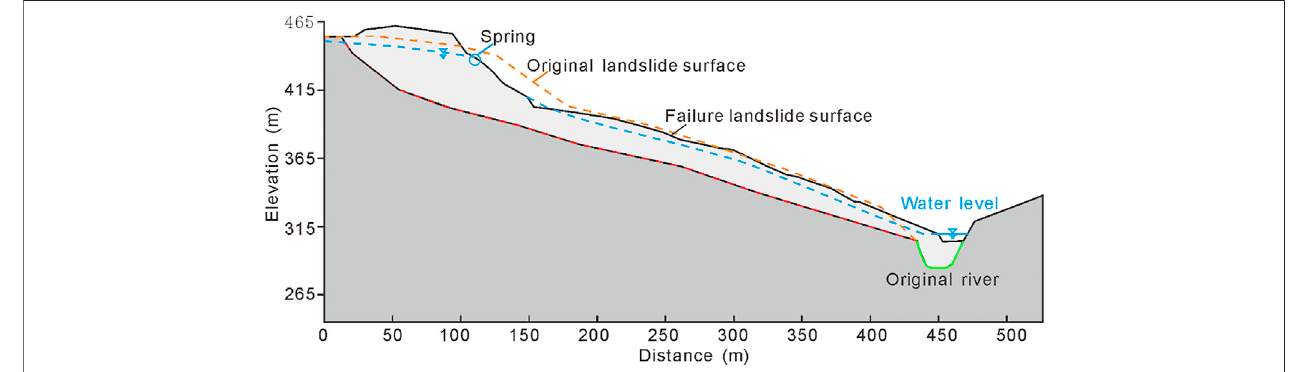
FIGURE 14 | Pro fi le 1 – 1 ′ of the accumulation area (shown in Figure 9 ).